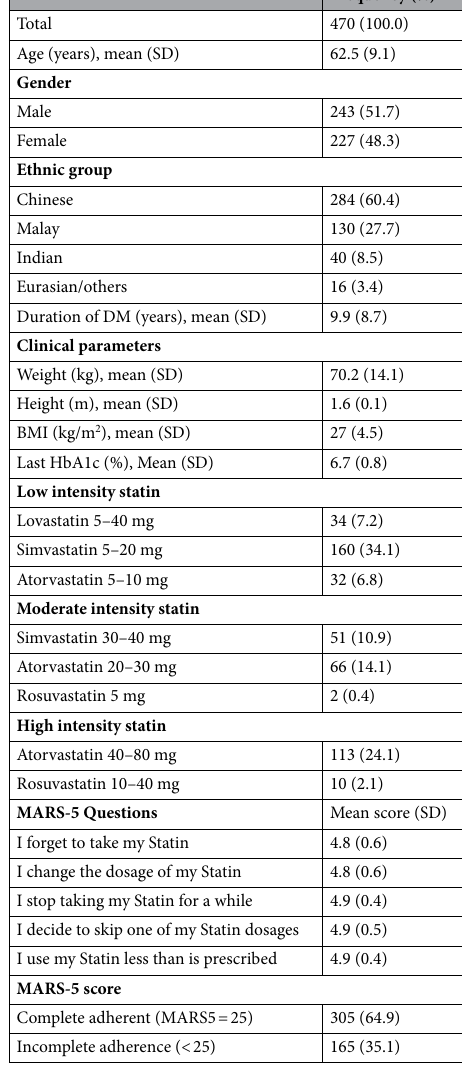
Table 1. Study population demographics (n = 470) distribution of statin type and intensity, and MARS-5 score distribution for adherence to statin treatment.